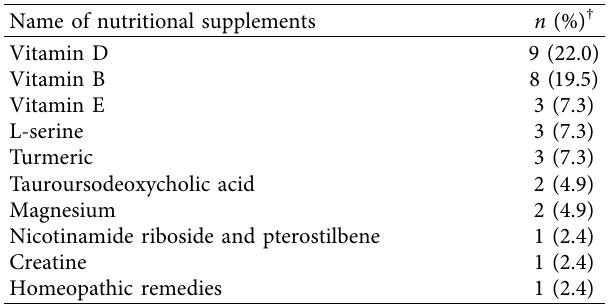
Table 2: Patients reporting use of nutritional supplements against